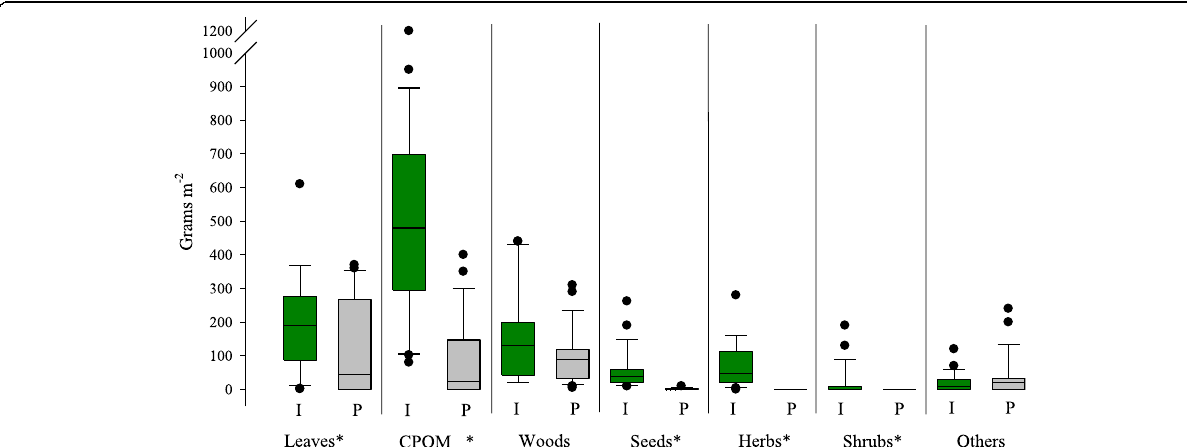
Fig. 3 Coarse particulate organic matter (CPOM) sampled in intermittent rives (I, green color) and perennial rivers (P, gray color),* p value< 0.05. *The boundary of the box closest to zero indicates the 25th percentile, a line within the box marks the median, and the boundary of the box farthest from zero indicates the 75th percentile. Whiskers (error bars) above and below the box indicate the 90th and 10th percentiles; mean values are shown with a dotted line)